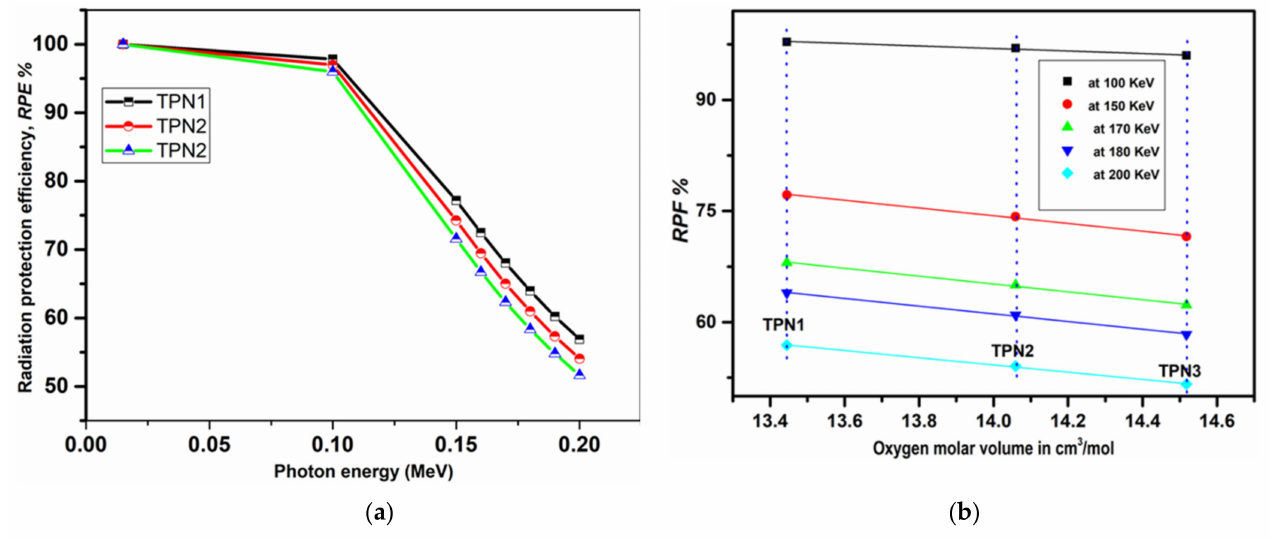
Figure 8. ( a ) RPE% with photon energy (in MeV) of fabricated glasses; ( b ) RPE% with oxygen molar volume of fabricated